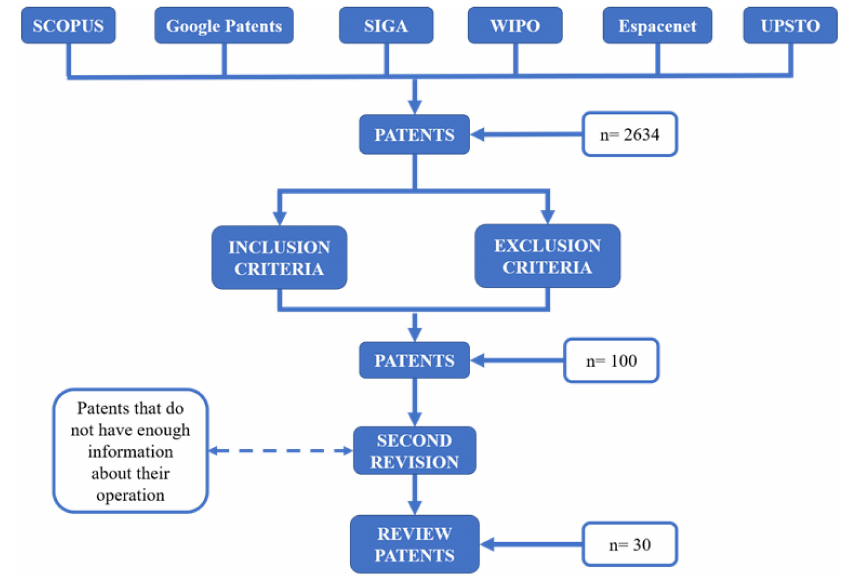
Figure 2. Patent analysis flow